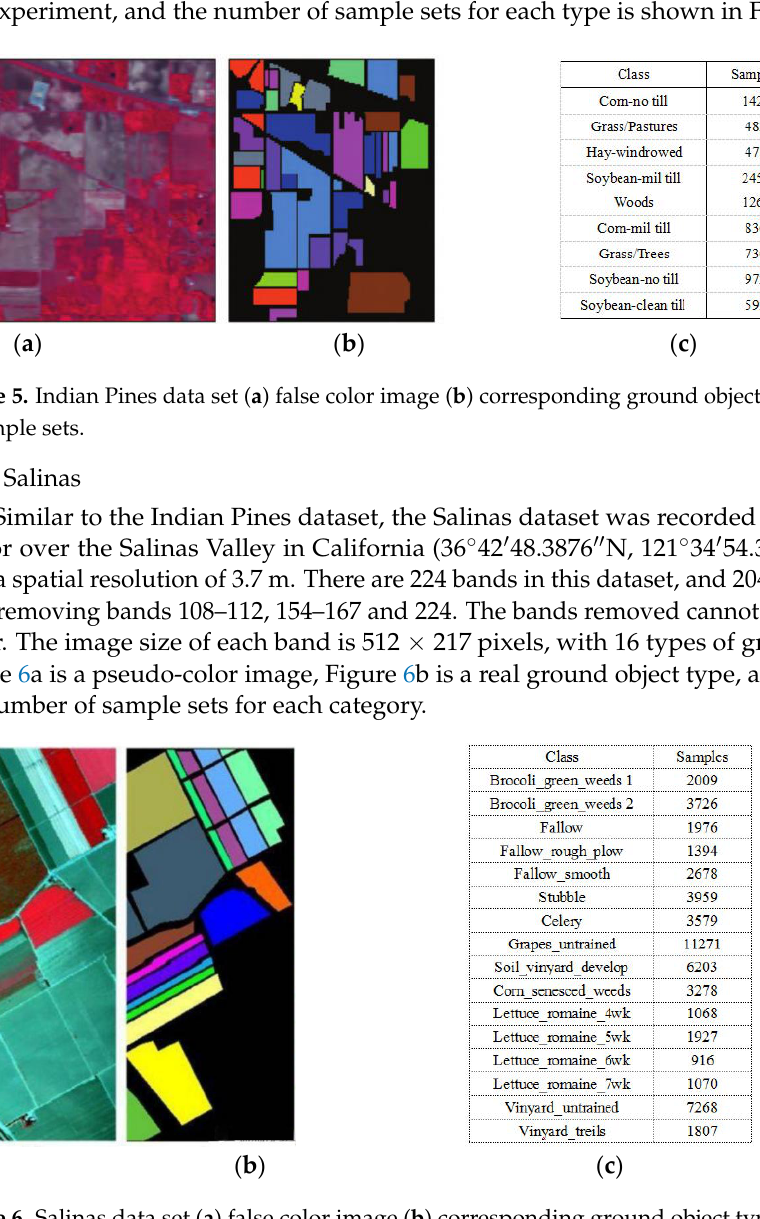
Figure 6. Salinas data set ( a ) false color image ( b ) corresponding ground object type ( c ) number of sample sets.